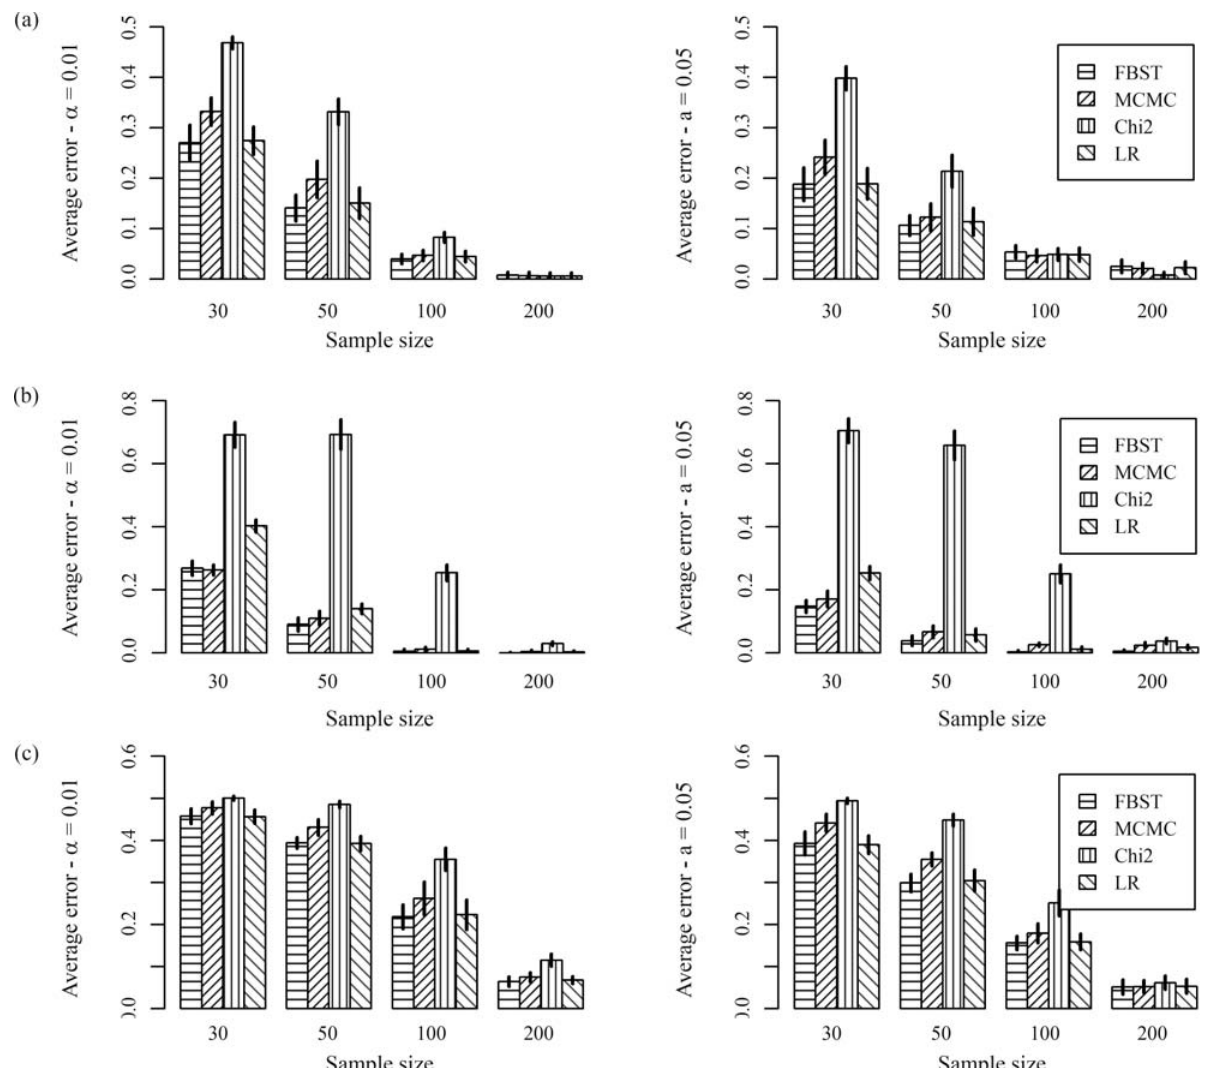
Figure 3 - Average error rates for FBST, MCMC, Chi-square and Likelihood-ratio for simulated data based on examples from Louis and Dempster (1987) (a), Guo and Thompson (1992) (b) and Wordsworth et al. (1992)